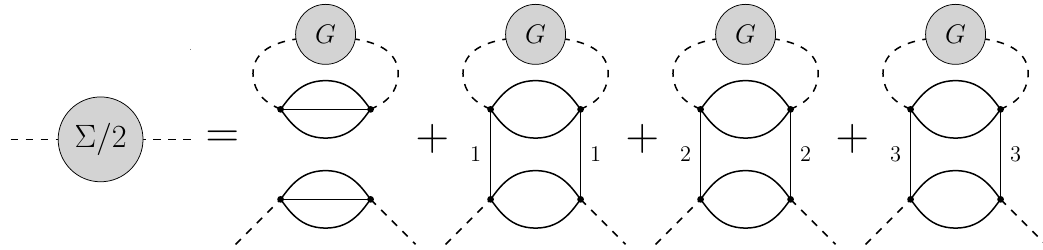
Figure 2 . Graphical representation of the Schwinger-Dyson equation (3.4) for the self-energy, at leading order in N . For simplicity, we have not represented the contractions of spinor indices, and we have left the summation over X